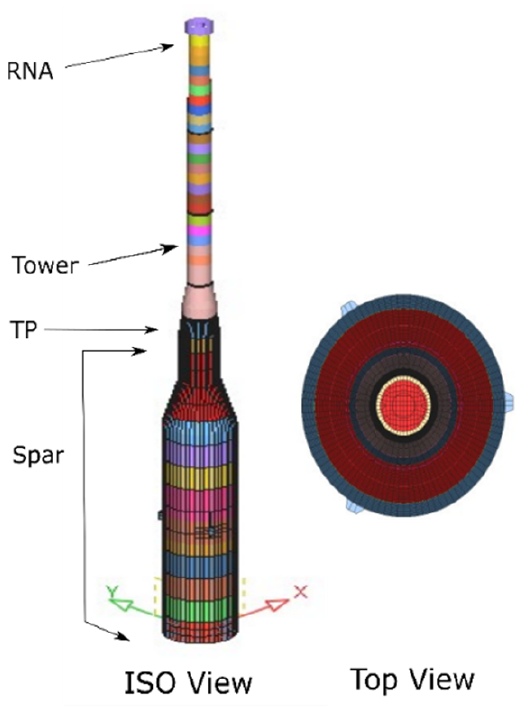
Figure 8. 3D finite element model of a spar structure.